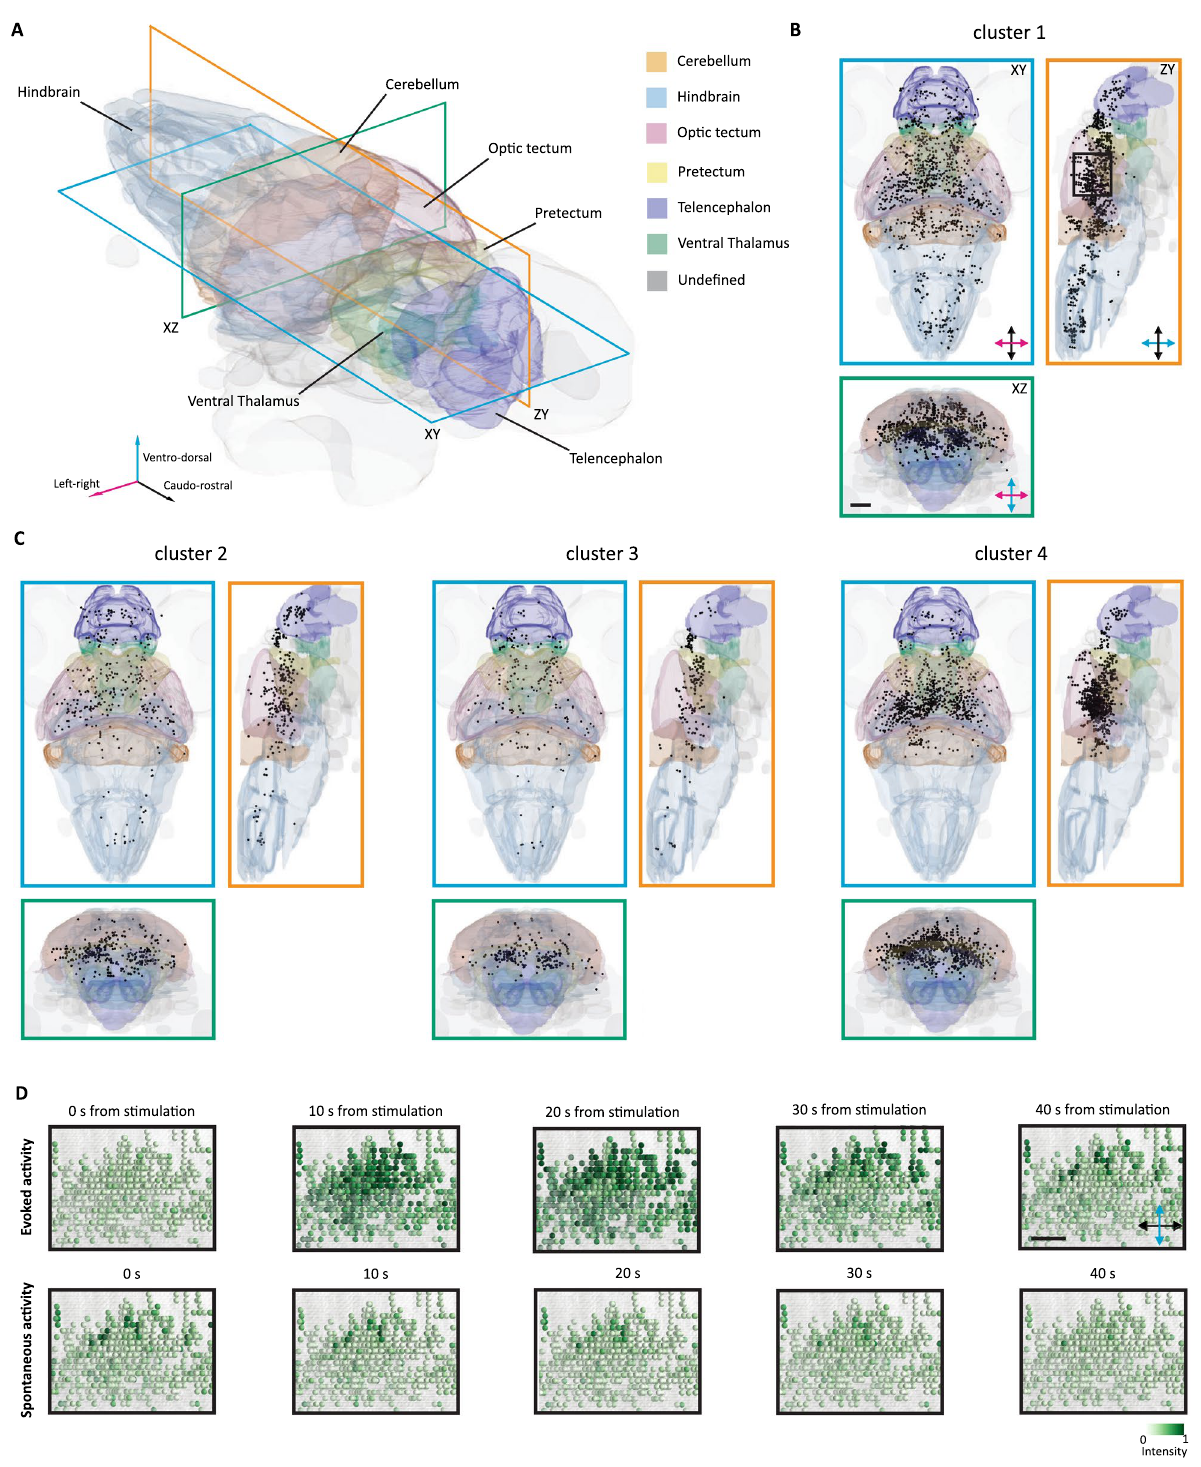
Figure 5. Anatomical representation of the identified clusters of visually responsive cells. ( A ) Three- dimensional representation of the brain of the larva with some of the most prominent region indicated. Three sectioning planes are overlaid to indicate the corresponding viewports for the following orthoviews. ( B ) Horizontal (cerulean), sagittal (orange) and coronal (bluish-green) views of the brain, with the projection of the stimulus-responsive cells belonging to the cluster 1. The black box indicates the area of the inset in D. Scale bar = 100 μm. ( C ) Horizontal, sagittal and coronal views of the brain, with the projection of the stimulus- responsive cells belonging to the cluster 2, 3 and 4. ( D ) Field of view extracted from the longitudinal plane in ( B ). In the top row, evoked activity of visually responsive cells is reported for 40 s from the onset of the stimulus. In the bottom row, spontaneous activity of the same cells is reported for 40 s. Scale bar = 50